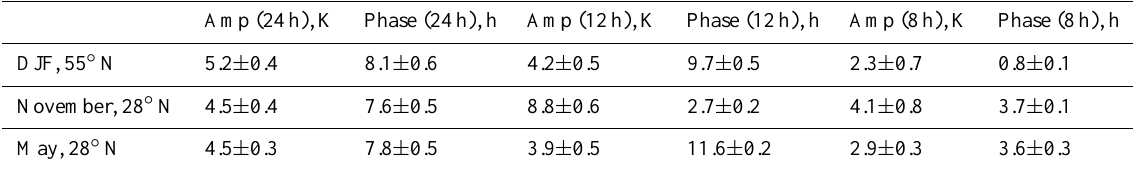
Table 3. Diurnal, semidiurnal and terdiurnal tidal-fit parameters at 89km